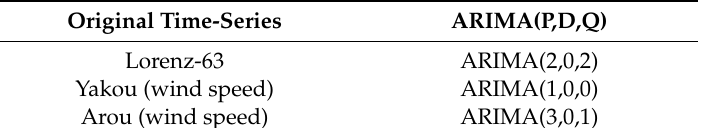
Figure 7. Origin series of wind speed and the ACF and PACF of the series.